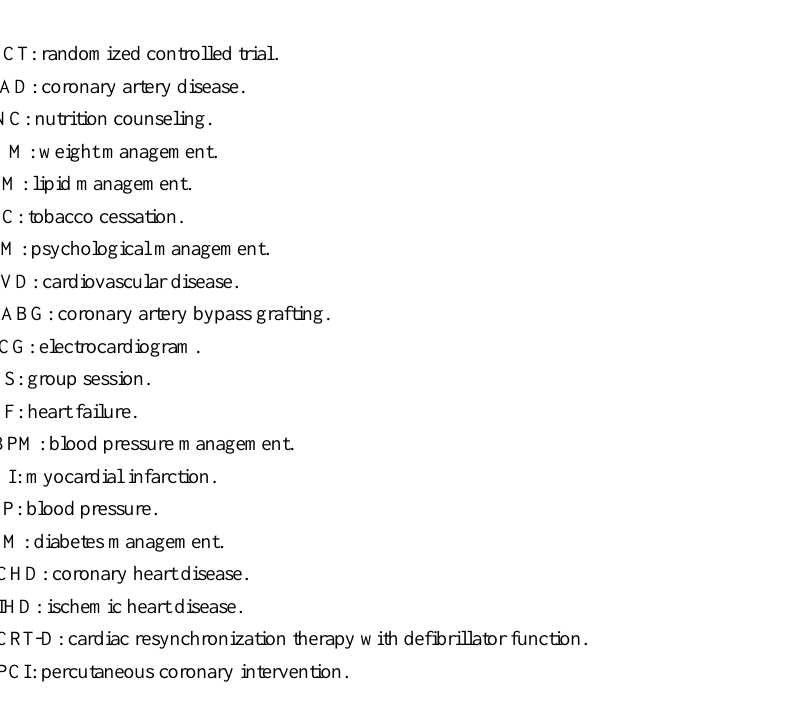
Table 2. Summary of the studies included in the analysis (n=31).